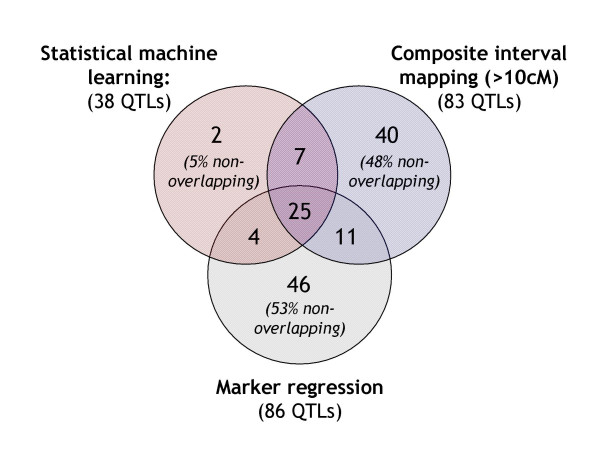
Cross-validation of QTL. Overlaps among QTL detected by SML, MR and CIM at a p < 0.05 level. QTL in common between each pair of methods were identified as described in the section entitled 'Comparisons between QTL-detection methods and map versions' in Methods. The reported numbers are the sums across all nine traits investigated in this study.